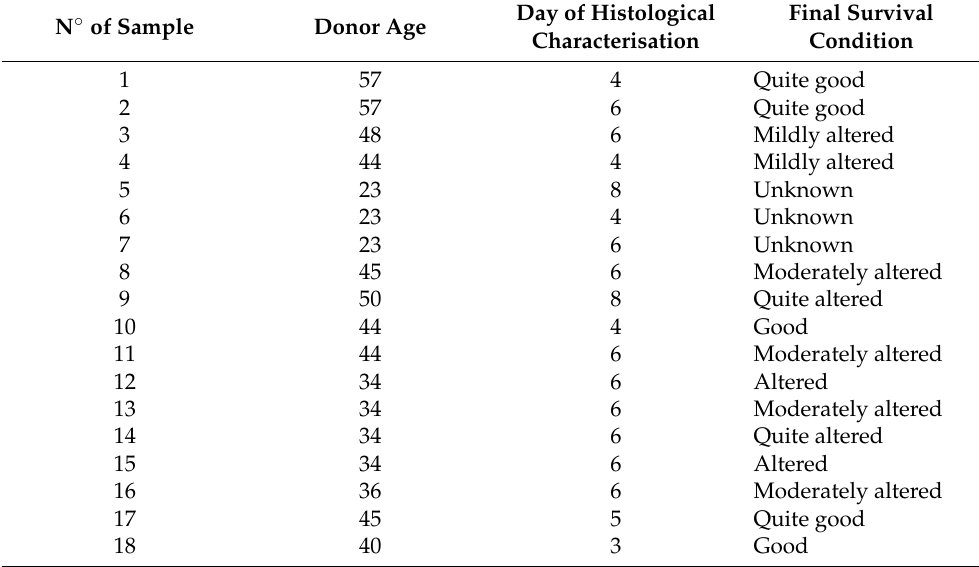
Table 1. Donor information and final survival condition of the panel of 18 skin explants. All skin explants were from female donors of phototype 1 or 2, except n ◦ 16 which was of phototype 5. The final survival condition was unknown for explants 5, 6 & 7 because of the failure of the histological test. N ◦ of Sample